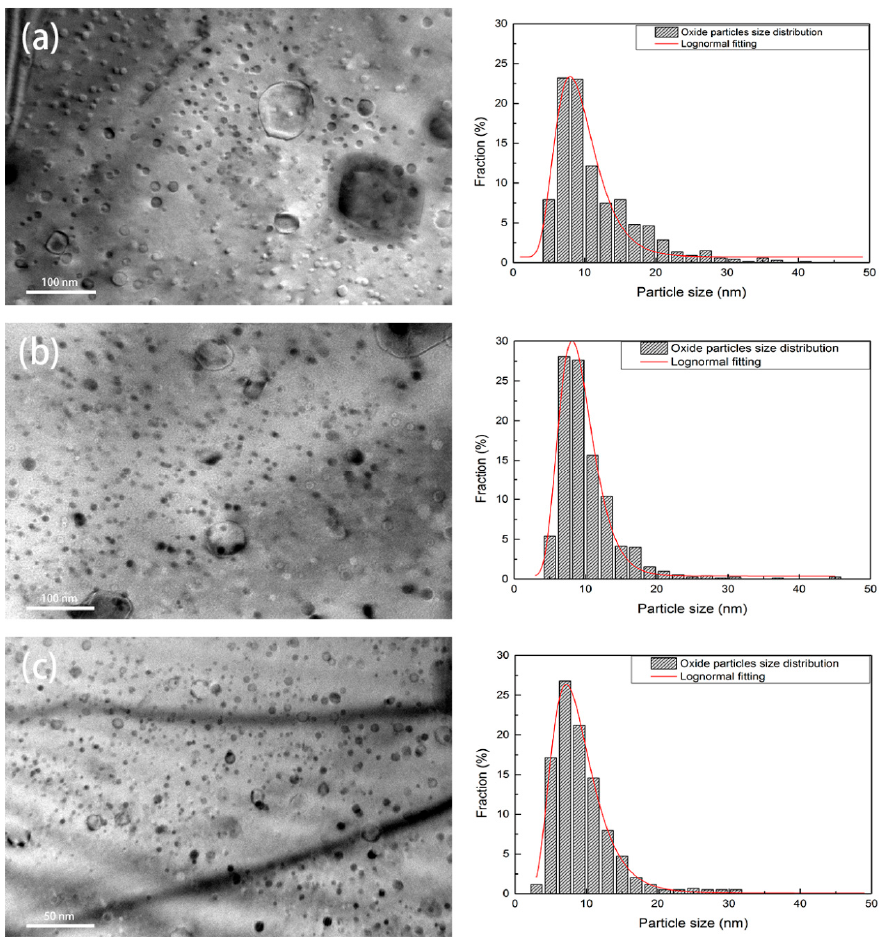
Figure 5. TEM images and size distribution of the oxide nanoparticles in: ( a ) 16Cr ODS steel; ( b ) 16Cr-0.3Zr ODS steel; and ( c ) 16Cr-0.6Zr ODS steel. Table 2. The average diameter d p , inter-particle spacing λ and number density n V of oxide particles